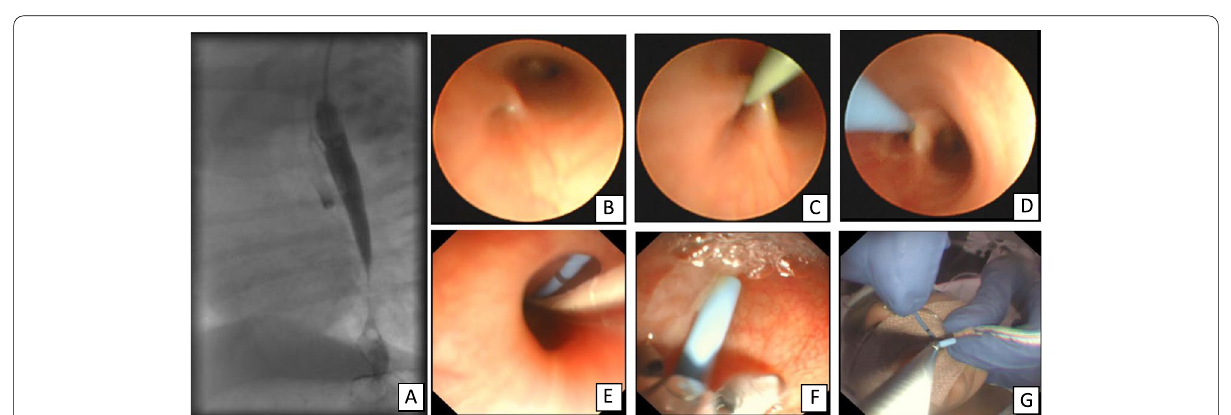
Fig. 1 A Fluoroscopy image delineating the trajectory of this H-type fistula. B Bronchoscopy image of the tracheal opening of the fistula with the carina visible in the distance. C Bronchoscopy image of the guidewire being place through the working channel into the fistula. D Bronchoscopy image the ureteric catheter being advanced over guidewire. E Oesophageal endoscopy demonstrating nasogastric tube (white) and ureteric catheter (blue) from the oesophageal end of the fistula. F Ureteric catheter being grabbed with the forceps via the working channel of the gastroscope. G Distal end of ureteric catheter being taken out of the mouth while the anaesthetist is securing the proximal end of the catheter and the endotracheal tube